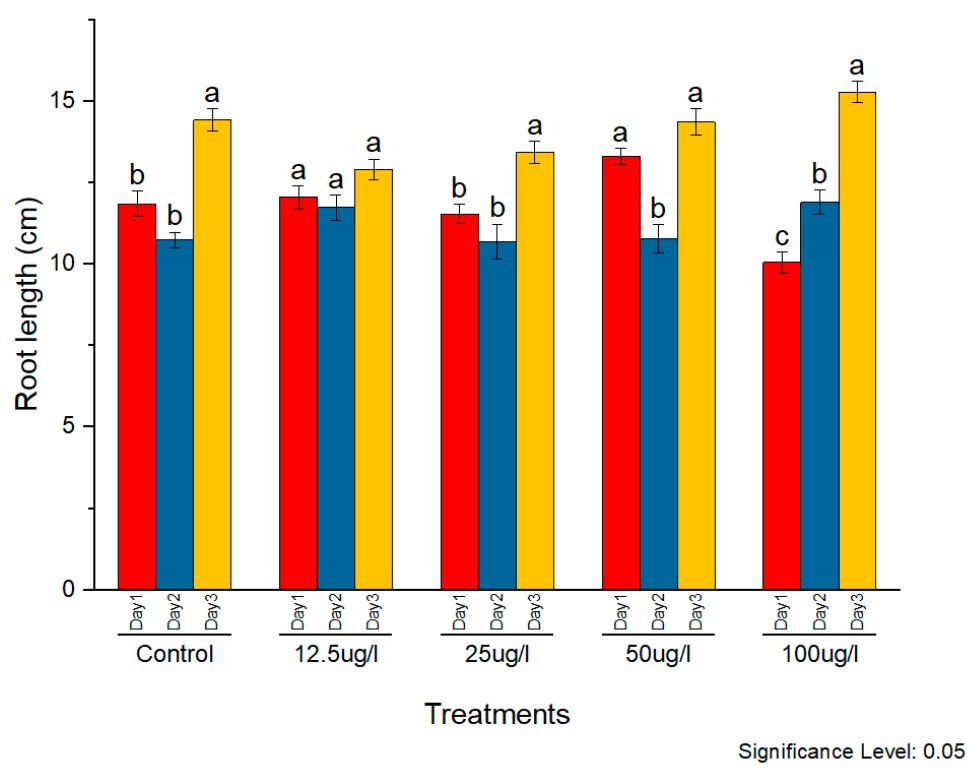
Figure 9. Phytotoxic effects of AgNPs on plant root, a and b indicates two significance sub groups based on Latin Square Design (LSD) value.